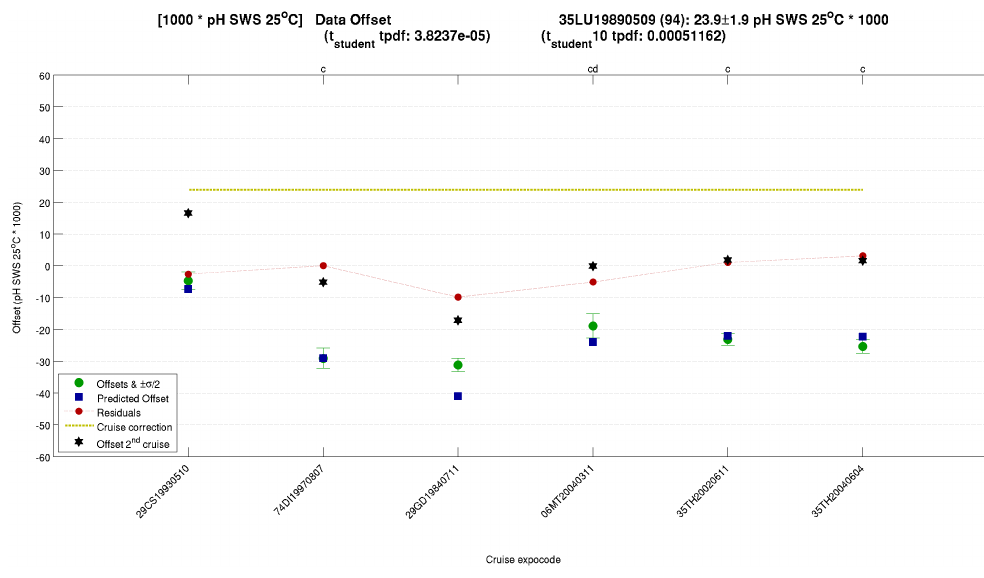
Figure 14. Cruise crossover information plot for 33LK19960415 (84).